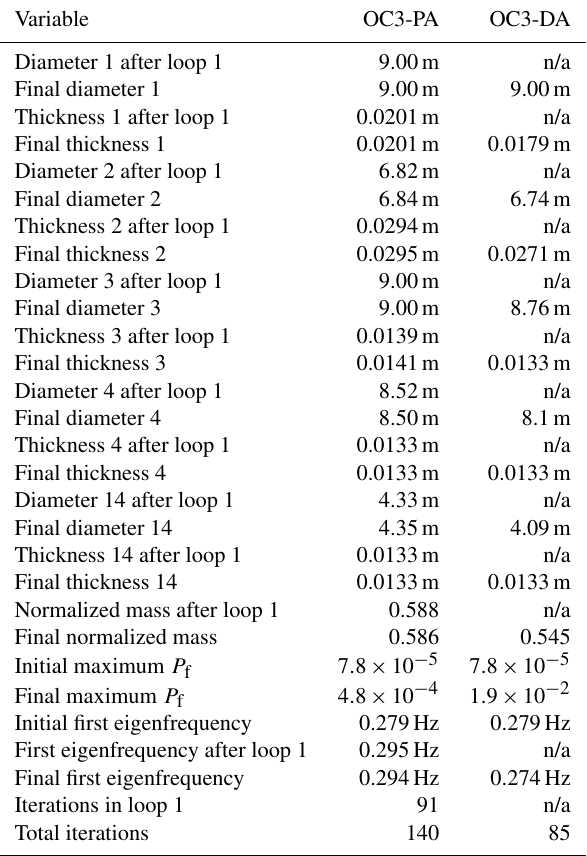
Table 7. Selected summary results of cases OC3-PA and OC3-DA. Design variable numbers run from 1 (bottom element) to 14 (top